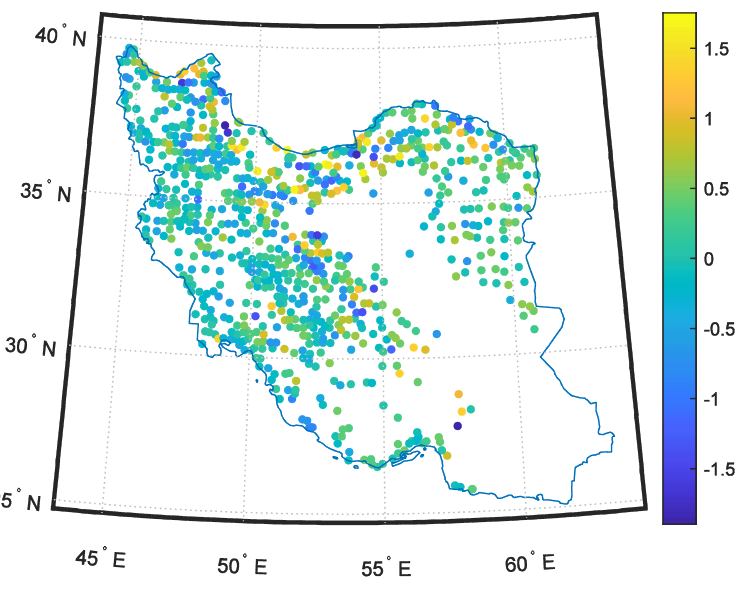
Figure 6 . RMS of the GO_CONS_GCF_2_DIR_R5 model in 841 GPS/Levelling points up to the degree of